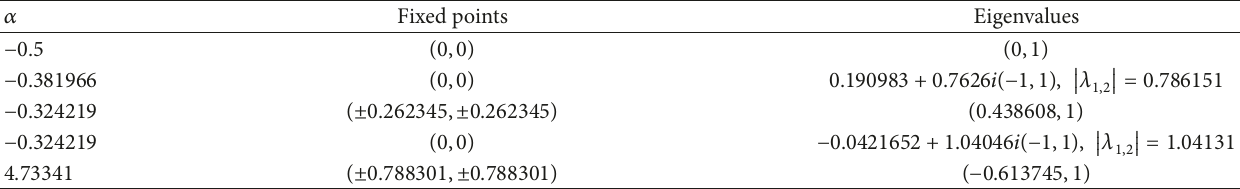
Table 2: Fixed points without repelling